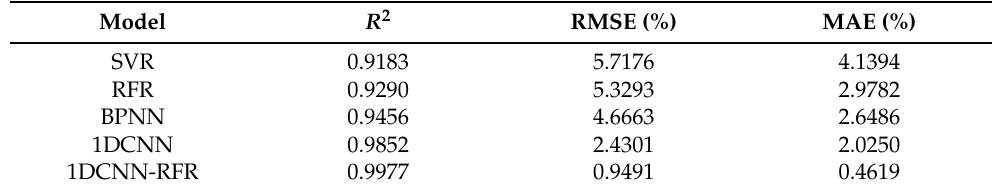
Table 5. Evaluation of the regressions from the five models using the test set in Experiment A using three